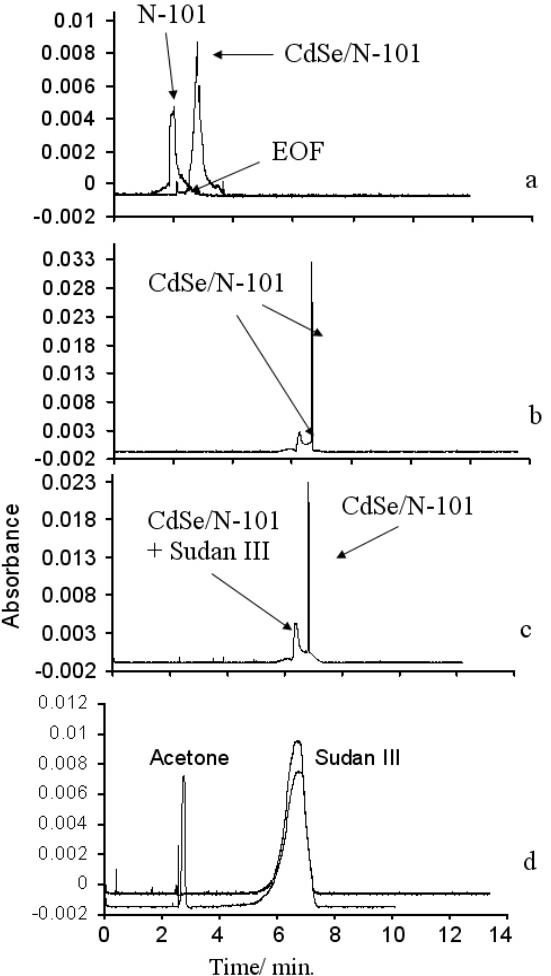
Figure 6. Comparison of CZE and MEKC for the separation of CdSe/N- 101 QDs and the peak position for MEKC markers. (a) CZE mode: electrolyte buffer, 20 mM sodium tetraborate; (b-d) MEKC mode: electrolyte buffer, 50 mM SDS containing 10 mM sodium tetraborate. Samples analyzed: (a) sample N-101 (10%) and CdSe/N-101 QDs prepared in 5% N-101 (overlaid); (b) CdSe/N-101 prepared in 1.5% N-101; (c) the same sample as (b) containing Sudan III (95 µL of QDs sample with 5 µL of saturated Sudan III in 0.5 M SDS); (d) acetone and Sudan III markers added to electrolyte buffer (50 mM SDS/10 mM sodium tetraborate) (double injections were shown to confirm the system reliability). Applied voltage for all separations +20 kV. Detection UV-Vis, λ = 330 nm. Sample injection: 50 mbar/0.3 min. CdSe/N-101 QDs size, 3.4